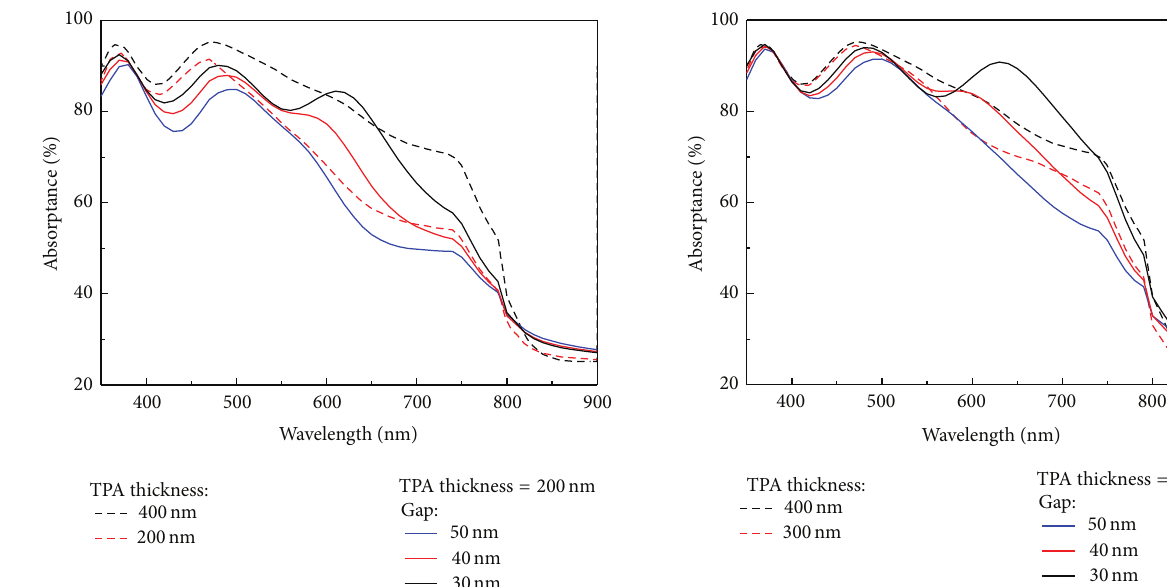
Figure 4: The red (black) dashed line indicates the absorptance of the TPA/ITO/glass when the TPA thickness is equal to 200 nm (400nm). The blue, red, and black lines are the absorptance of the TPA/ITO/glass with the Cu nanoplasmonic structure when the long axis of the Cu nanoparticles is 100nm.